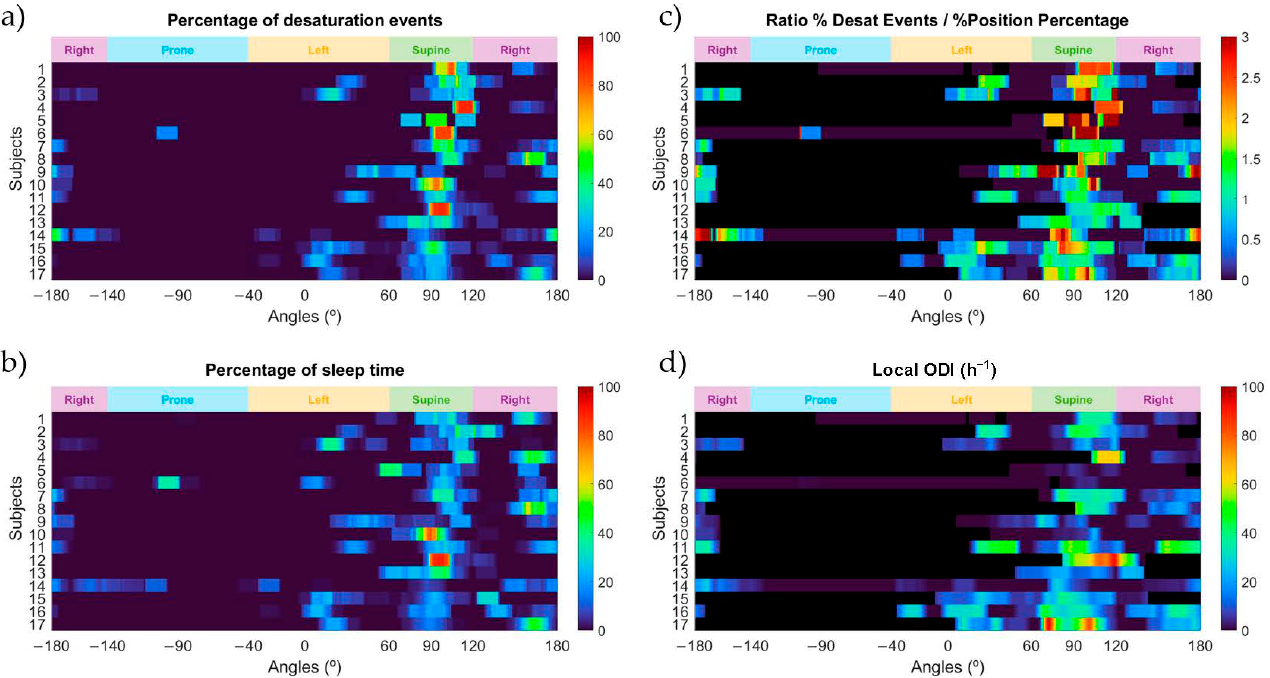
Figure 5. Heatmaps of the percentage of desaturation events ( a ); the percentage of sleep position time ( b ); the ratio between the percentage of desaturation events and the percentage of sleep position time ( c ); and the local ODI ( d ) for each sleep position angle and for each of the subjects in this study. Black colors shown in the heatmap indicate that the ratio and the local ODI could not be calculated for that specific angle due to no time slept on it.